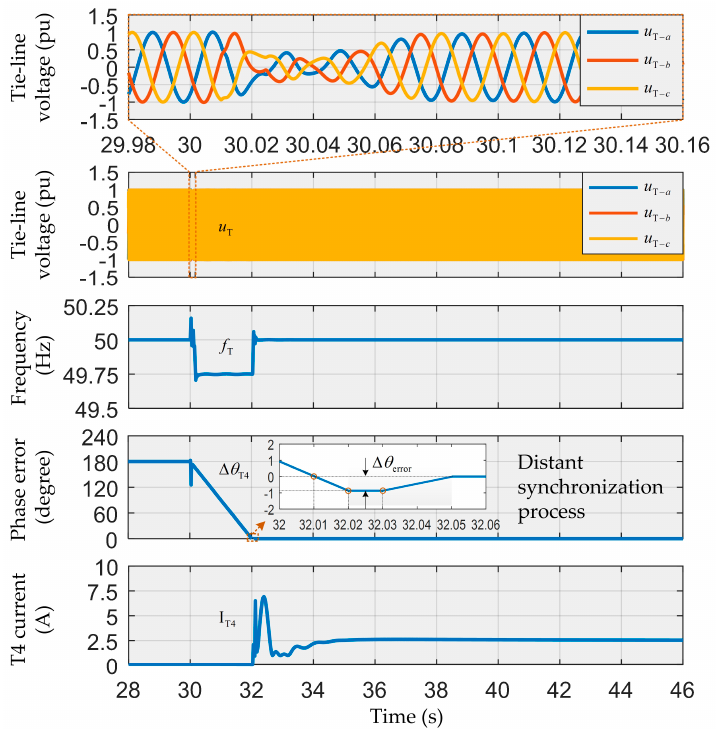
Figure 8. Major changes of electric quantity at the DN side in Scenario 2. Electronics 2020 , 9 , 18